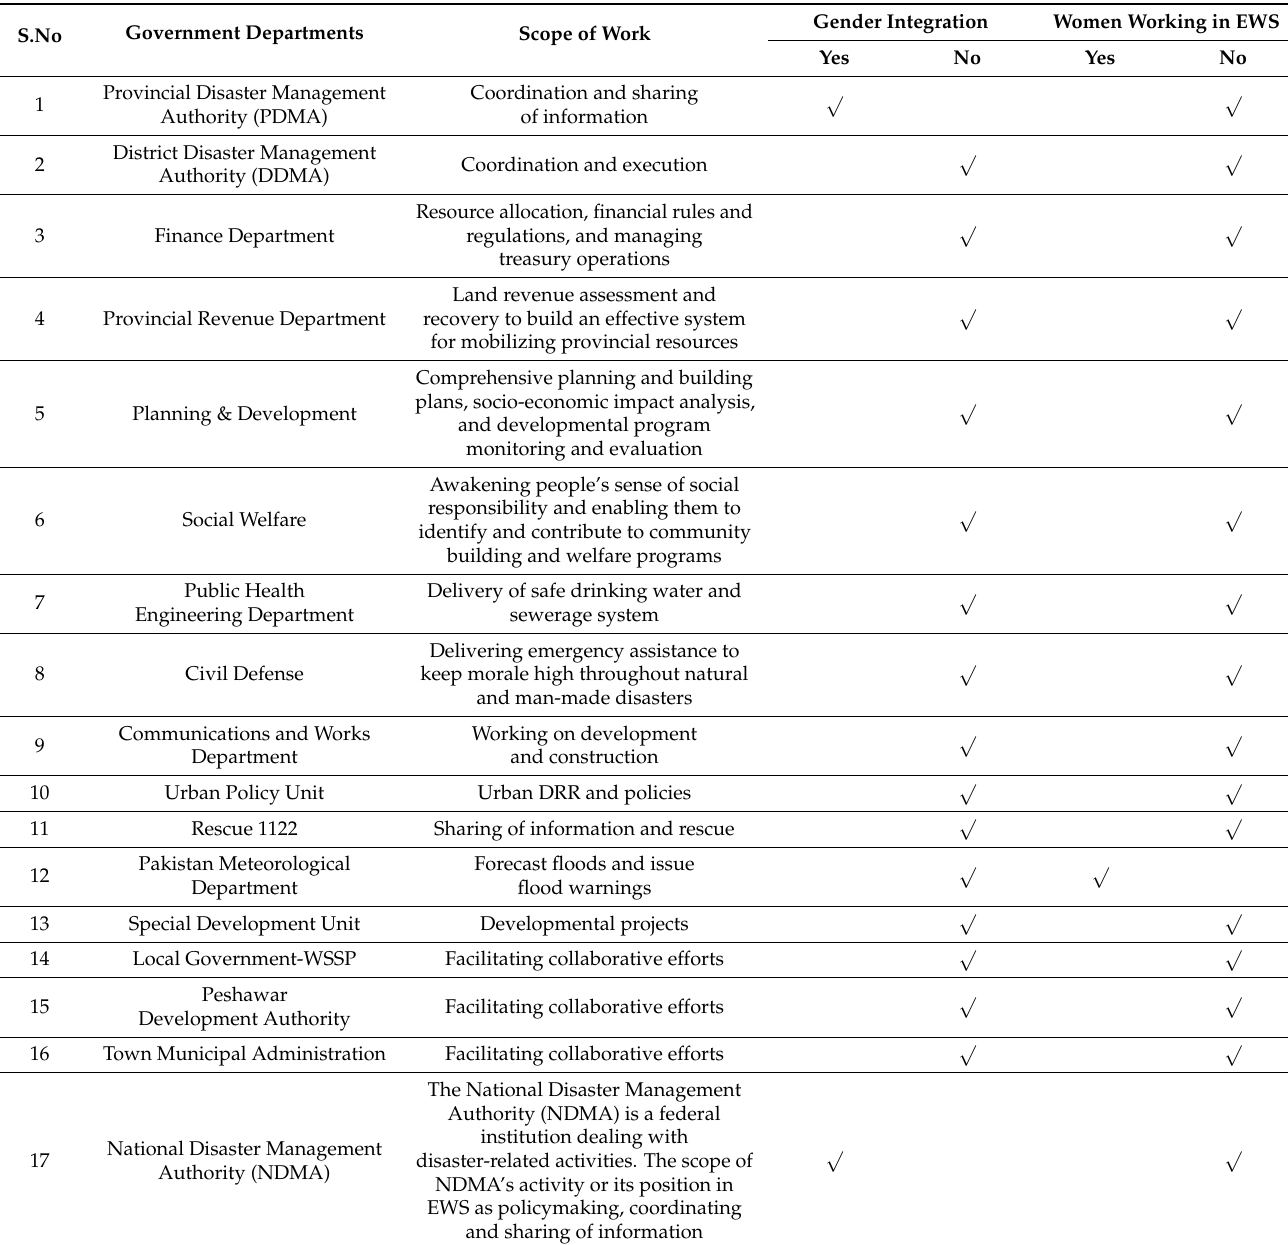
Table 3. Description of the results from the institutional